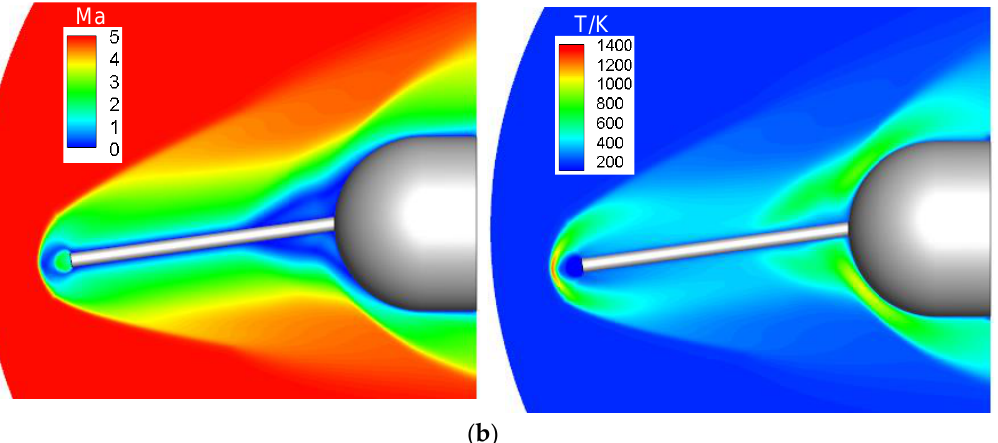
Figure 7. Comparison of Mach number and temperature distributions: ( a ) α = 8°, η = 0°; ( b ) α = 8°, η = 8°.